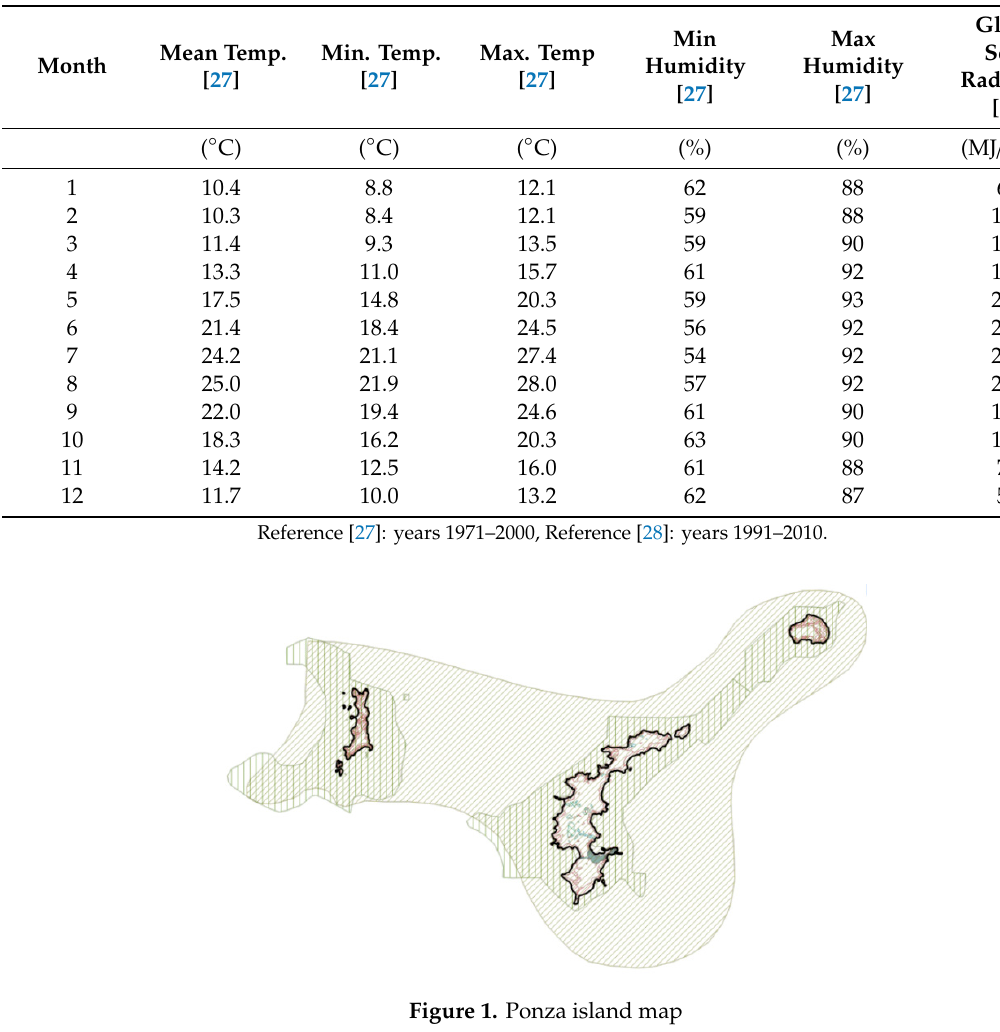
Table 1. Mean climate data values.